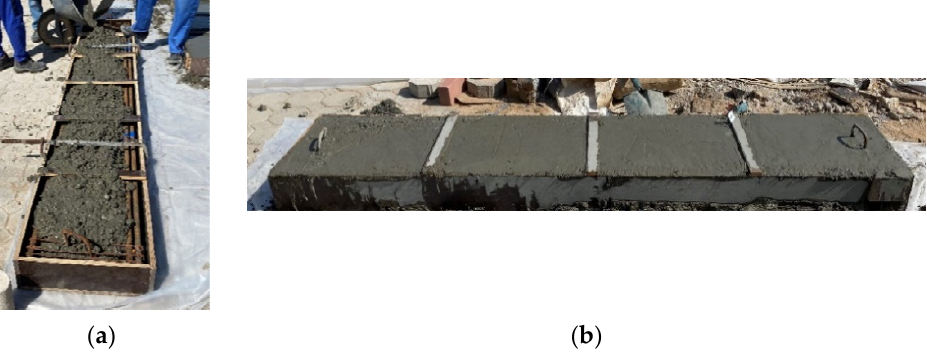
Figure 2. Casting of steel-fiber-reinforced concrete beams: ( a ) placement of concrete; ( b ) a trowel-finished concrete beam.